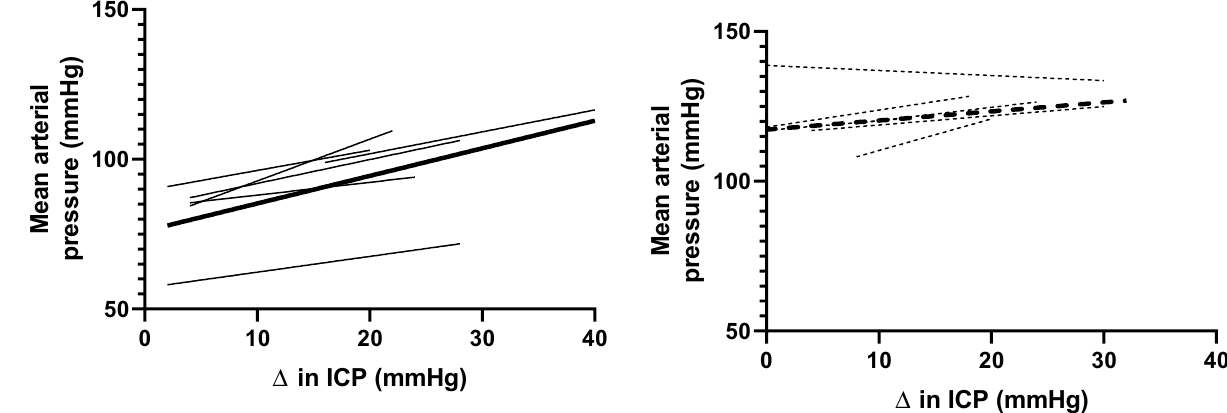
Figure 3. Average and individual regression lines showing the relation between changes in arterial pressure as a function of changes in intracranial pressure for normal (left panel) and hypertensive (right panel) groups. The thin lines are individual animals and the thick lines are the mean regression lines for each group.